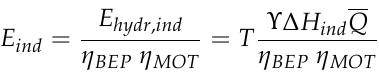
Figure 10. Time series of flow ( a ) and head loss ( b ) through the valve; pattern Δ(cid:1834),(cid:1843)((cid:1872)) ( c